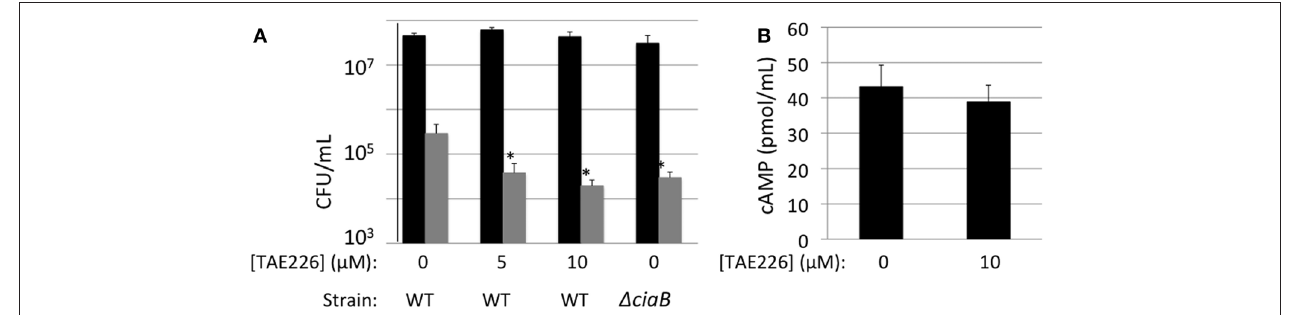
infected cells in the absence of inhibitor, as judged by the Student’s t -test ( P < 0 . 05). (B) Delivery of the CiaC-ACD fusion protein was assayed at 30min post-infection in the presence of 0 or 10 μ M TAE226. The values shown were normalized by subtracting the background cAMP value obtained for the flgE mutant (i.e., Cia secretion negative) containing each ACD fusion construct from the values obtained for the wild-type strain. The error bars represent one standard deviation from the mean. The amount of cAMP produced in the presence of TAE226 was not significantly different from the value obtained in the absence of TAE226, as judged by the Student’s t -test ( P < 0 . 05). Cells were treated with methanol (vehicle control), and trypan blue staining was performed to confirm that the solvent used for TAE226 did not affect cell viability (not